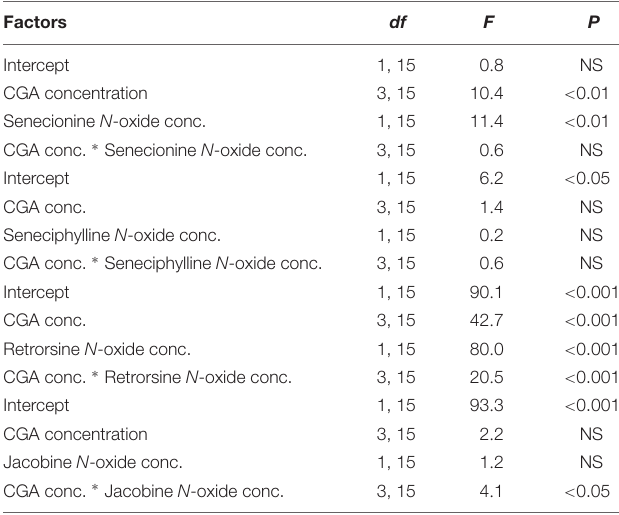
TABLE 3 | Two-way ANOVAs with PA N -oxide concentration and CGA concentration as fixed factors and the interaction effect (Equation 4) minus one (S X ∗ Y − 1) as a dependent variable.